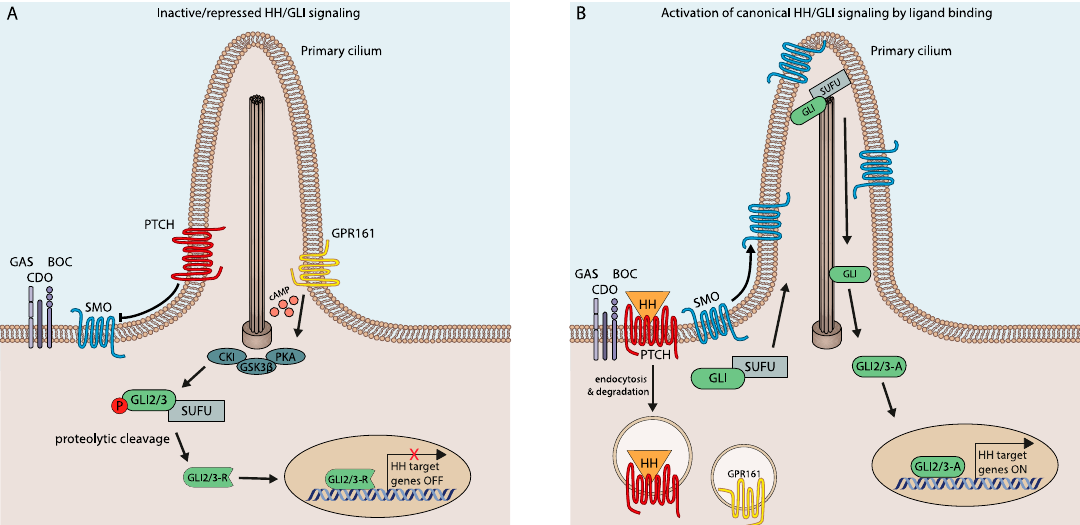
Figure 1. Canonical SMO-dependent HH / GLI signaling. ( A ) Pathway repression and GLI repressor formation in the absence of HH ligand protein. Unliganded PTCH1 prevents the ciliary translocation of the pathway e ff ector SMO. GRP161 contributes to pathway silencing by increasing cAMP levels and PKA activity, resulting in enhanced GLI repressor formation. ( B ) Binding of HH ligand protein to its receptor PTCH triggers endocytic internalization of PTCH, thereby allowing ciliary entry and activation of SMO. Ciliary SMO attenuates PKA activity, thereby promoting the formation of unprocessed GLI activator forms and transcriptional activation of HH / GLI target genes, respectively.